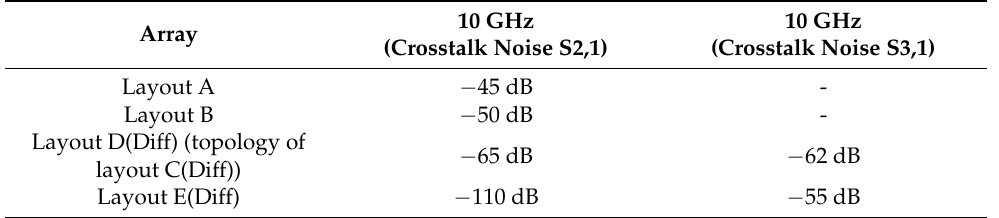
Figure 11. The crosstalk noises between layout D(Diff) and layout E(Diff). ( a ) crosstalk noise S2,1 of layout D(Diff) and layout E(Diff); ( b ) crosstalk noise S3,1 of layout D(Diff) and layout E(Diff). The crosstalk noises among layouts A, B, D(Diff) and E(Diff) are shown in Table 2. Therefore, the layout E has the greatest ability to reduce crosstalk noise in comparison with other arrays. Table 2. The crosstalk noises among layouts A, B, D(Diff) and E(Diff).